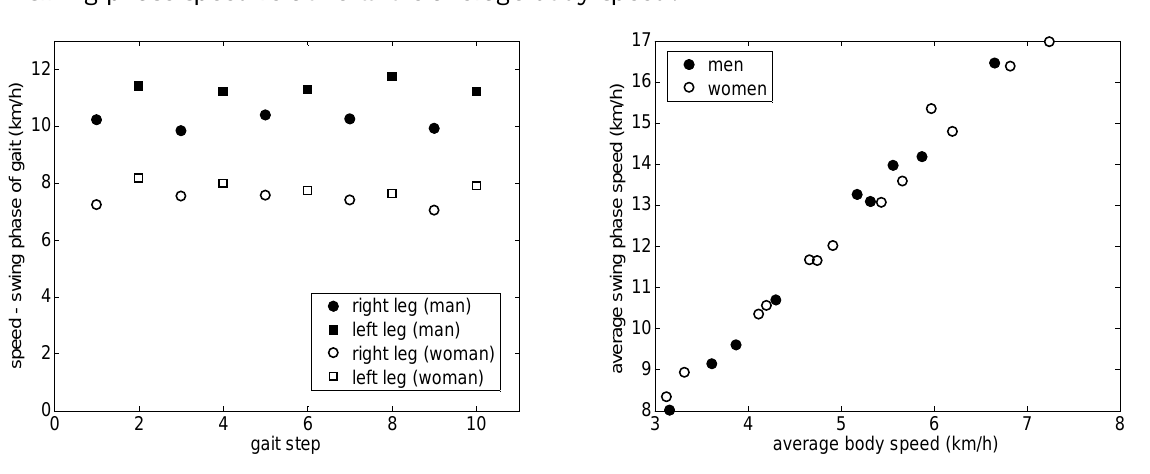
Figure 12. Left: Speed of the leg in the swing phase relative to the step. Right: Average swing phase speed relative to the average body